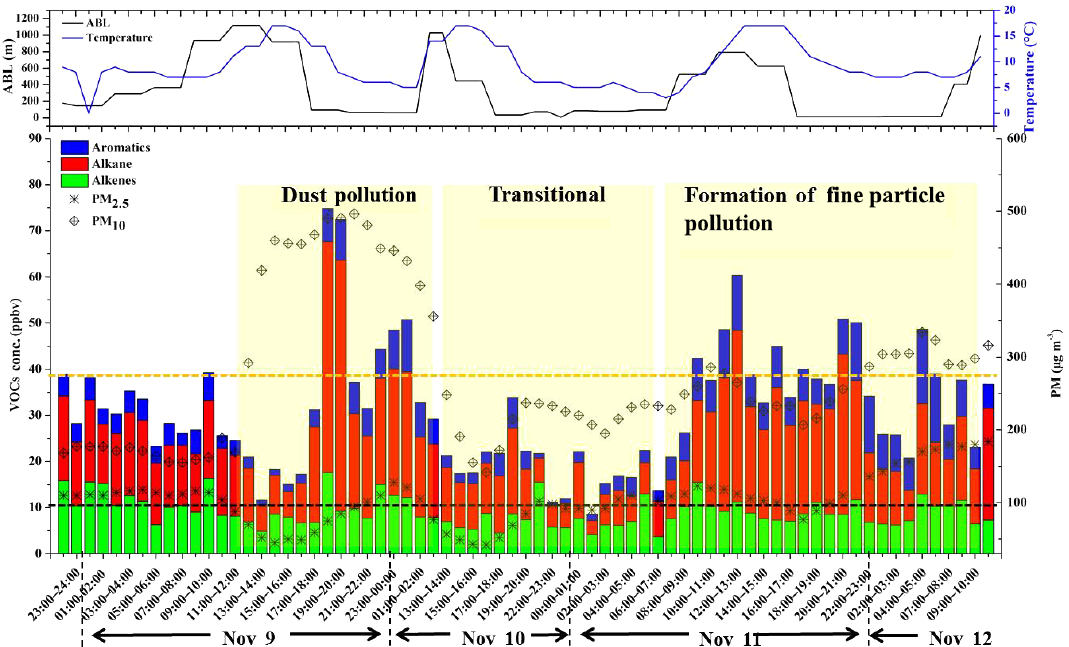
Figure 3. Temporal variations in volatile organic compound (VOC) concentrations and particle levels during the sampling period (9– 13 November